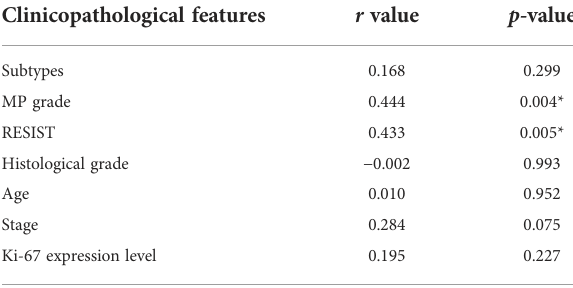
TABLE 2 The correlation analysis between expression level of hsa_circ_0058514 and clinicopathological features. Clinicopathological